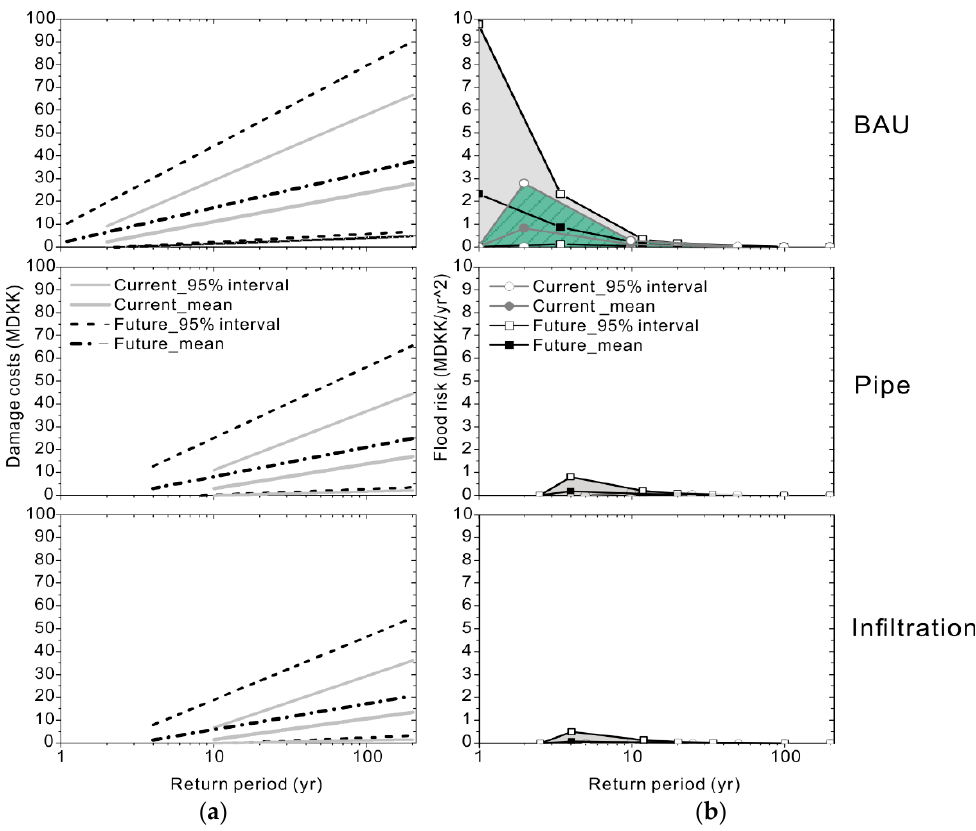
Figure 5. Uncertainty bounds of cost functions ( a ) and risk density curves ( b ) of the BAU and the two adaptation scenarios assuming current and future climatic conditions, respectively.